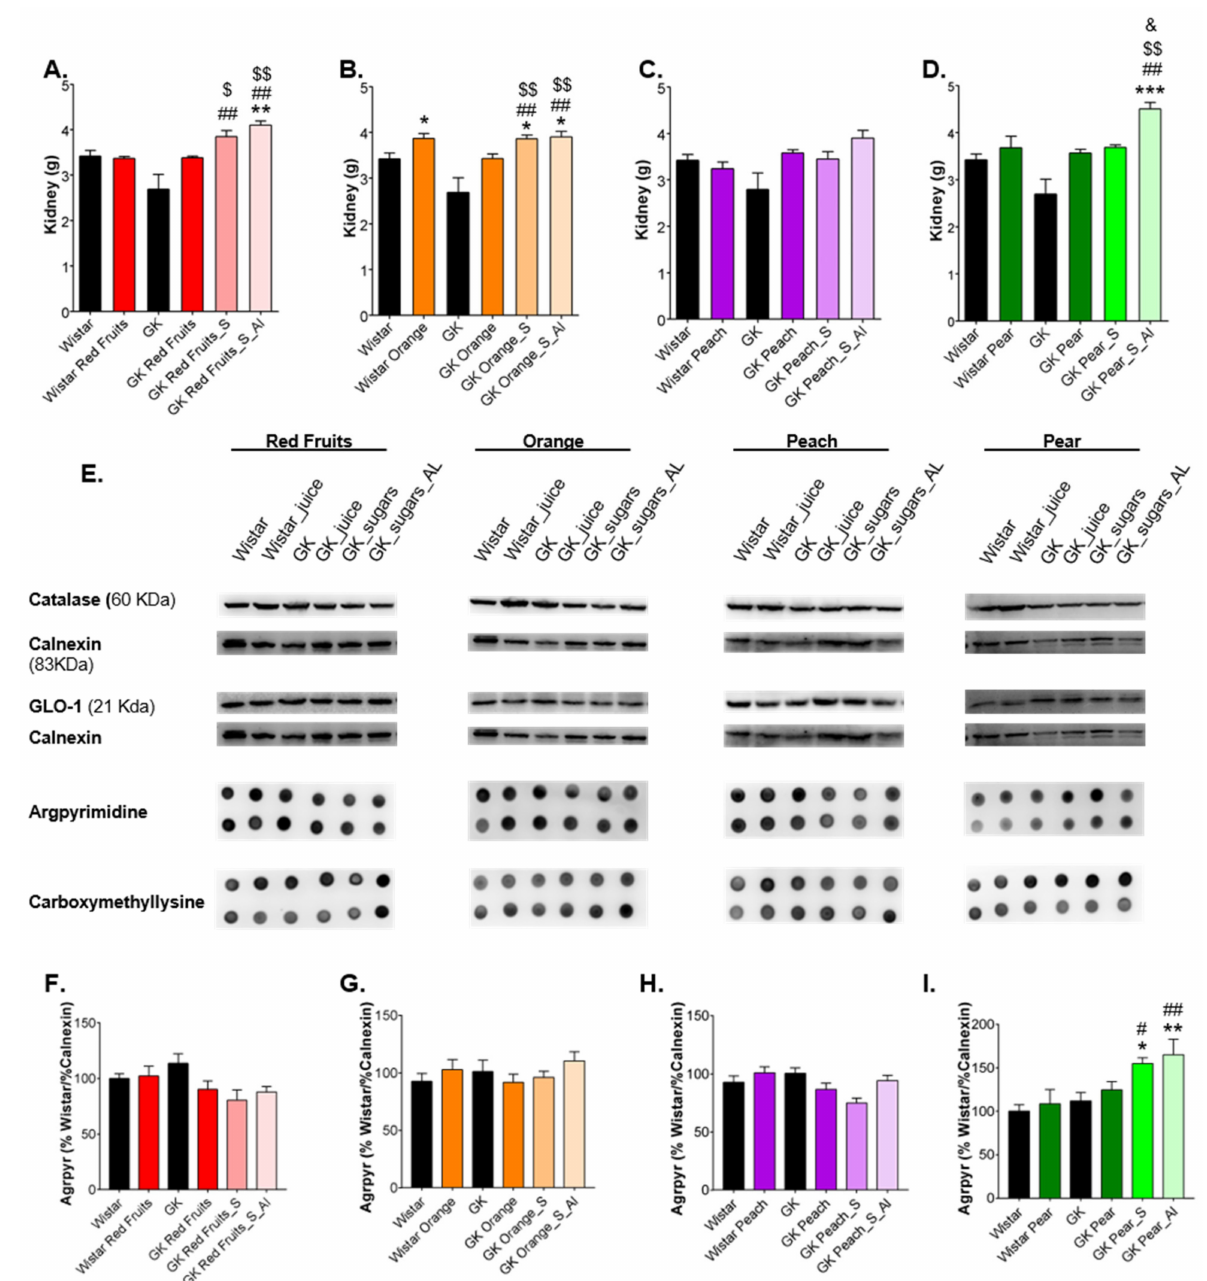
Figure 8. Kidney weight was recorded ( A – D ). Representative Western blot membranes of catalase and GLO-1 and dot blot membranes of CML in the kidney are shown in ( E ). Kidney argpyrimidine was determined by dot blot ( F – I ). * different from Wistar; # different from GK; $ different from GK_Juice; & different from GK_S. 1 symbol, p < 0.05; 2 symbols, p <